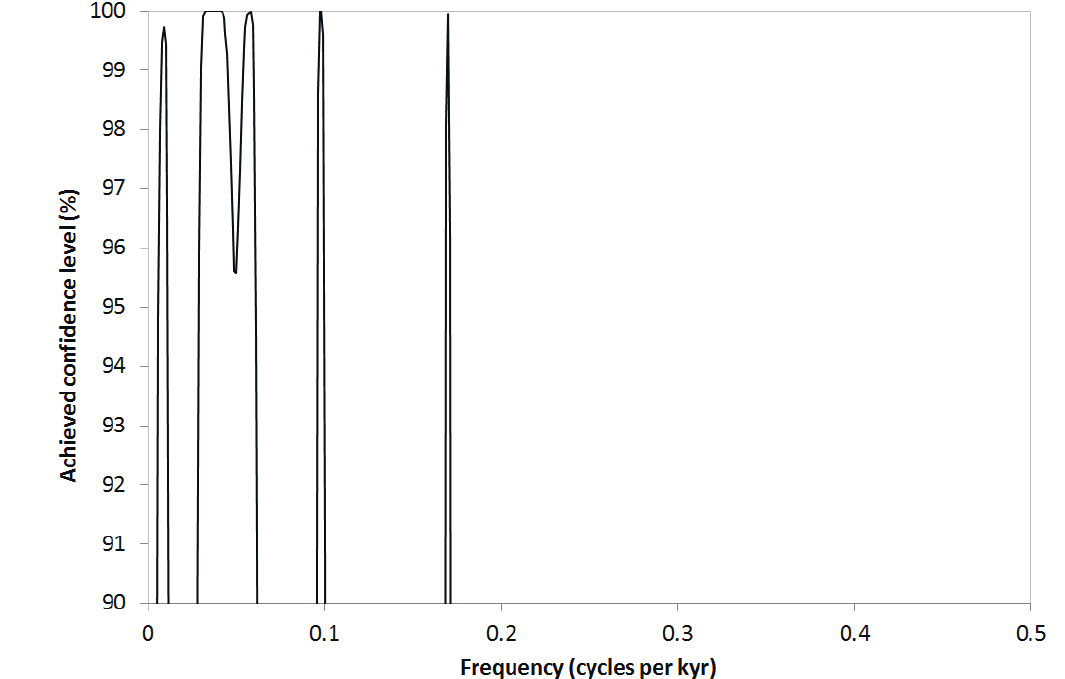
Figure 8. Achieved confidence level of the estimated power spectrum shown in Figure 7. It can be seen that all the spectral peaks have an ACL higher than 99.5%. The Nyquist frequency is 0.5, which corresponds to a period of 8